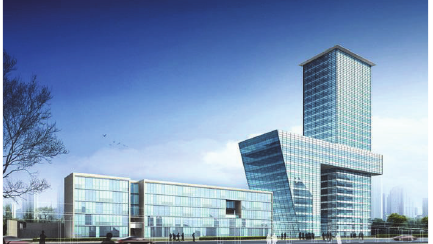
Figure 2: Architectural design of SHIDC.